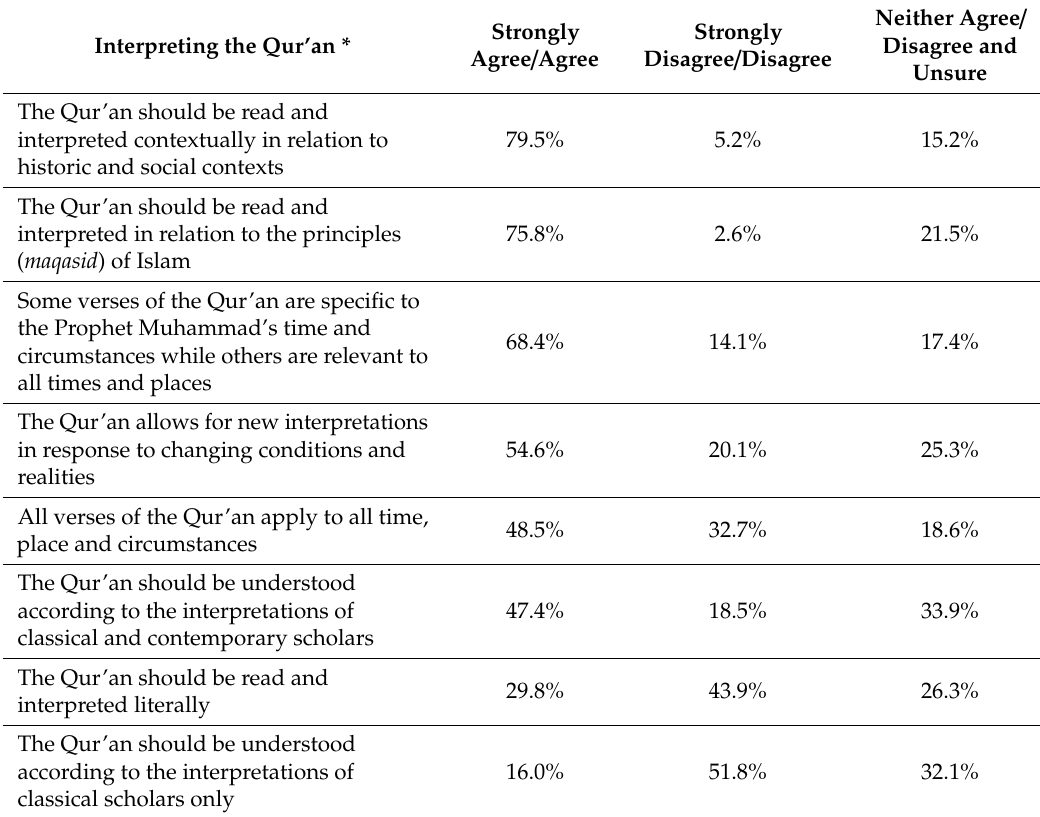
Table 3. Interpreting the